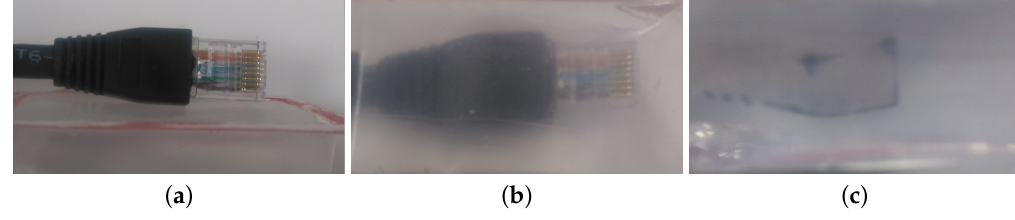
Figure 2. ( a ) contact of Ethernet cable with the silicone medium from the top; ( b ) direct observation through the silicone (0 degrees); ( c ) view of contact area considering 54 degrees to eliminate background